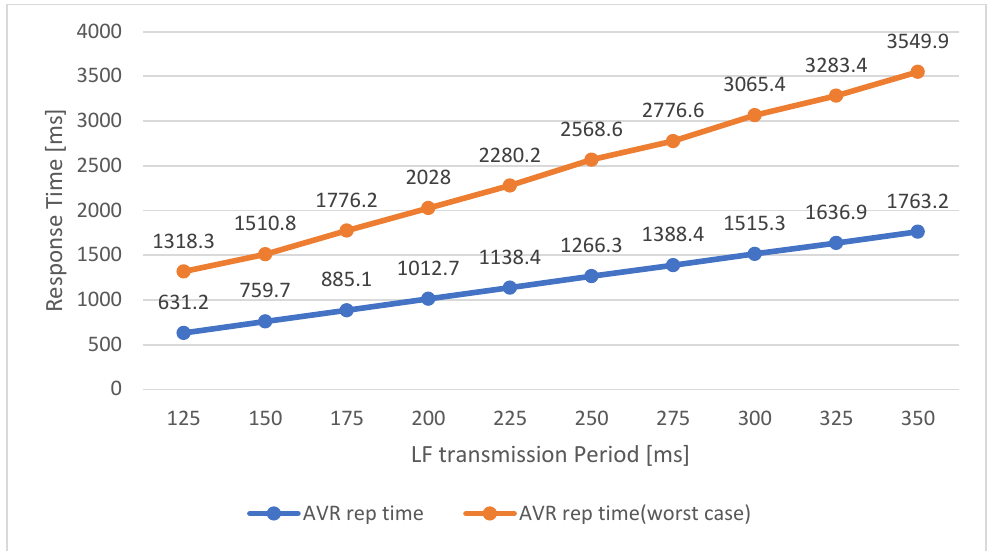
Figure 19. Response Time of Entrance Recognition System.